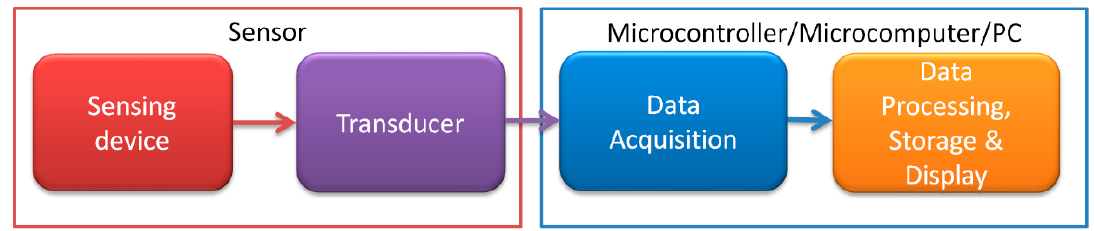
Figure 1. Simplified measurement chain schematic.